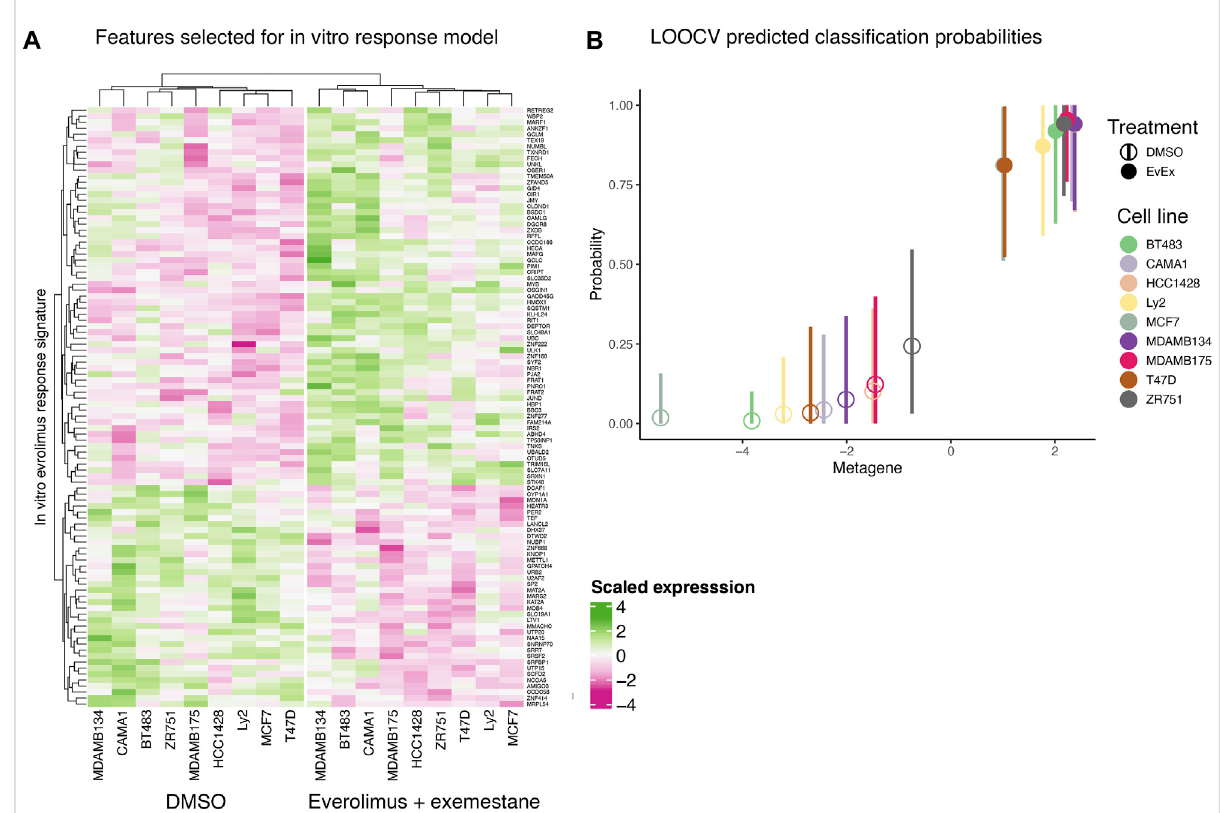
FIGURE 2 In vitro everolimus response signature and validation. (A) Heatmap of genes selected by the binary regression model to classify and predict everolimus response in 9 ER+/HER2- breast cancer cell lines. The genes in the signature are listed in rows and the columns indicate cell lines. Both rows and columns are shown as hierarchical clusters, with the columns split into two clades, resulting in clustering by treatment status (DMSO and everolimusplusexemestane). (B) LOOCVanalysisofthe9breastcancercelllines.HollowcirclesindicatecelllinestreatedwithDMSOwhilethe solid circles indicate cell lines treated with everolimus plus exemestane. The X-axis indicates metagene score, calculated from the principal component of thegenes in thesignature. Y-axis indicates predicted probability ofresponse, with avalue closer to 1 indicating response. The vertical bars indicate 95% con fi dence interval of the prediction